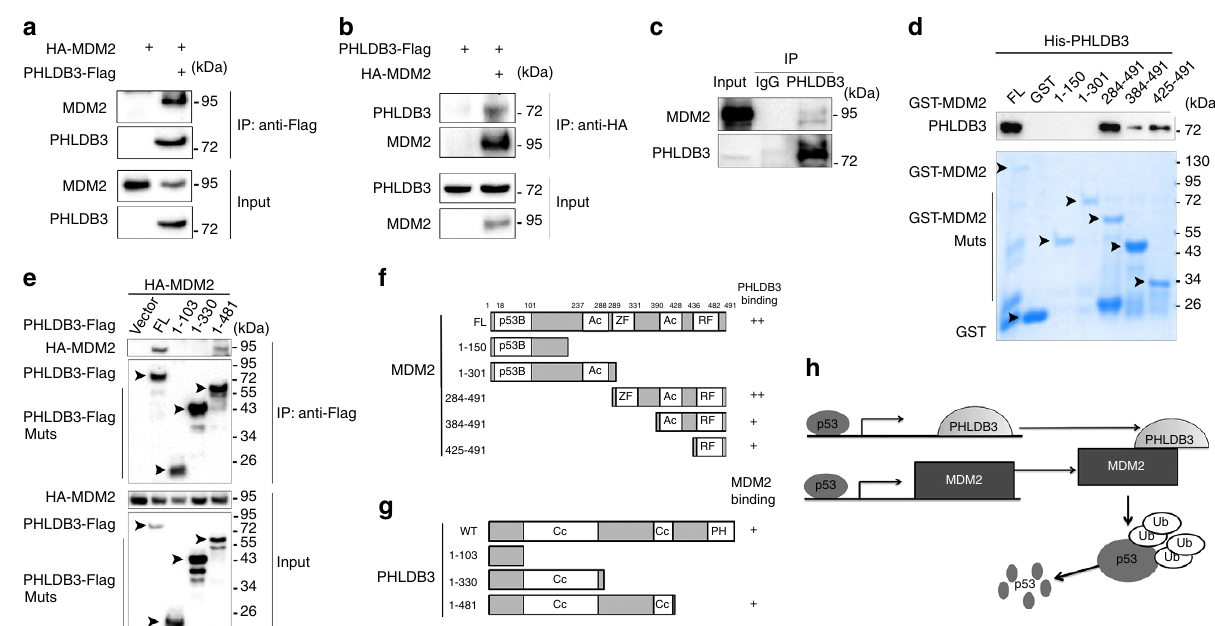
Figure 6 | PHLDB3 interacts with MDM2. ( a , b ) The interaction between ectopic PHLDB3 and MDM2. HEK293 cells were transfected with plasmids encoding PHLDB3-Flag and/or HA-MDM2 as indicated followed by Co-immunoprecipitation (Co-IP) assays using antibodies as indicated. ( c ) The association between endogenous PHLDB3 and MDM2 is detected after treatment of HCT116 p53 þ / þ cells with Doxorubicin. HCT116 p53 þ / þ cells were treated with Doxorubicin for 16h and MG132 for 6h before harvested for co-IP-IB assays using antibodies as indicated. IgG was used as a control. ( d ) Mapping the PHLDB3 binding domain of MDM2 by GST-pull down assays. Purified GST-tagged MDM2 fragments, including aa 1–150, aa 1–301, aa 284– 491, aa 384–491 or aa 425–491, and GSTprotein alone were incubated with purified His-PHLDB3 for one hour at room temperature. Bound proteins were detected by immunoblotting using anti-PHLDB3 or coomassie staining. ( e ) Mapping the MDM2 binding domain of PHLDB3 by Co-immunoprecipitation. HCT116 p53 (cid:2) / (cid:2) cells were transfected with an HA-MDM2-encoded plasmid along with the plasmid encoding each individual Flag-tagged PHLDB3 fragment as indicated. Co-IP assays were performed using the anti-Flag antibody followed by IB with the anti-HA antibody. ( f ) A schematic diagram of PHLDB3 binding regions on MDM2 based on the result from d . ( g ) A schematic diagram of MDM2 binding regions on PHLDB3 based on the result from e . ( h ) A model for the negative feedback regulation of p53 by the PHLDB3 and MDM2